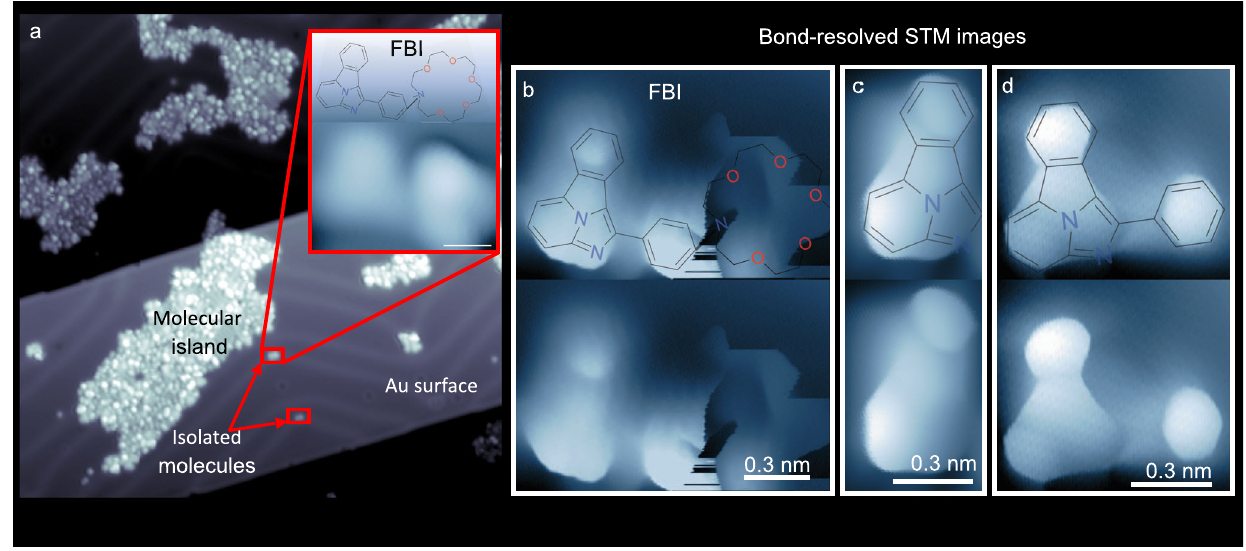
cd ]indolizine fl uorophore with phenyl ring and aza-crown ether (exactly the same molecule shown in the inset in a ); c benzo[ a ]imidazo[5,1,2- cd ]indolizine fl uor- without the crown ether. For clarity, the same image is shown twice, top one with and bottom one without the molecular model superimposed to guide the